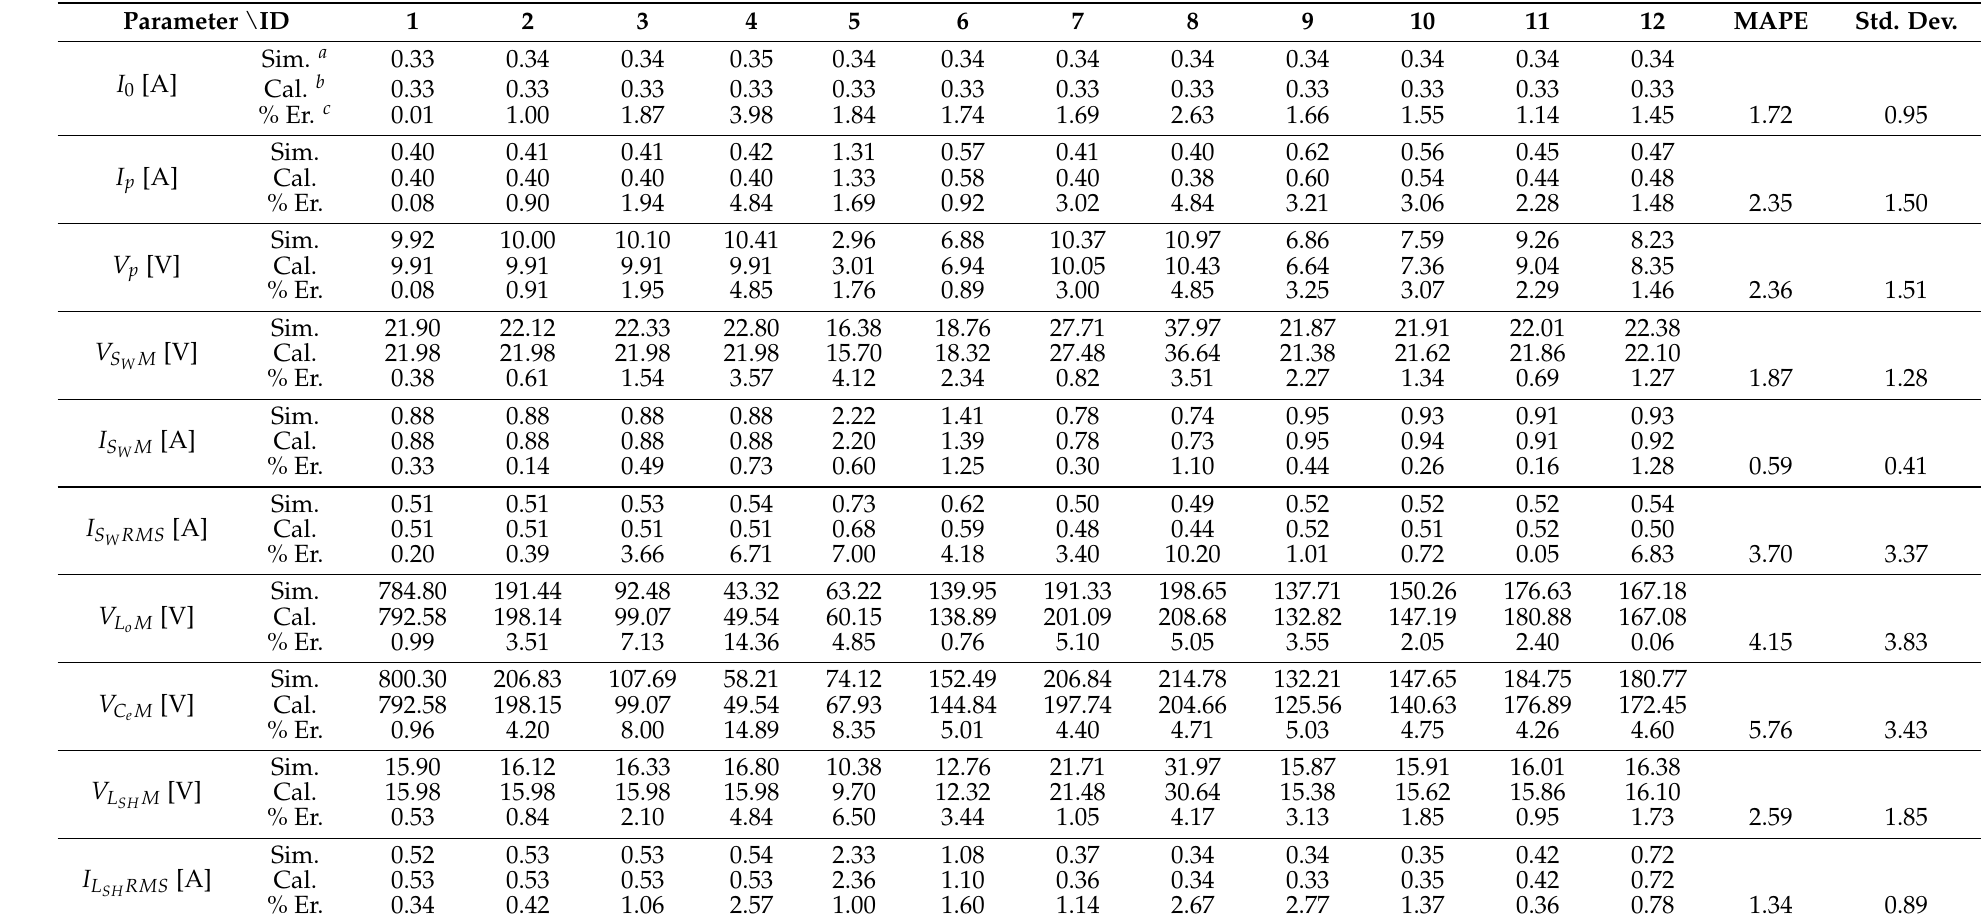
100. The absolute percentage error was calculated using all the precision provided by each